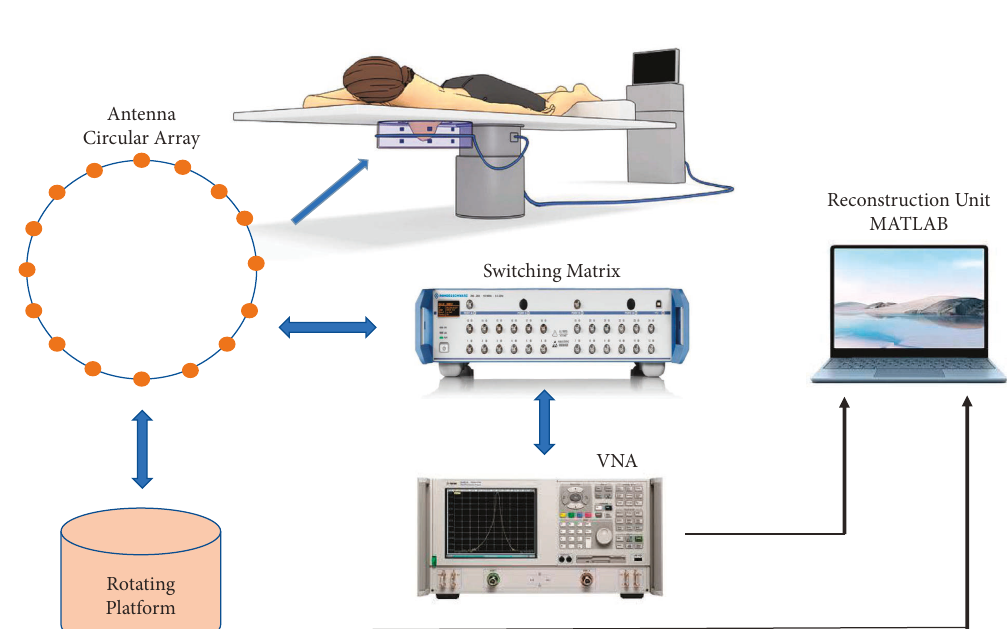
Figure 14: Setup of microwave imaging